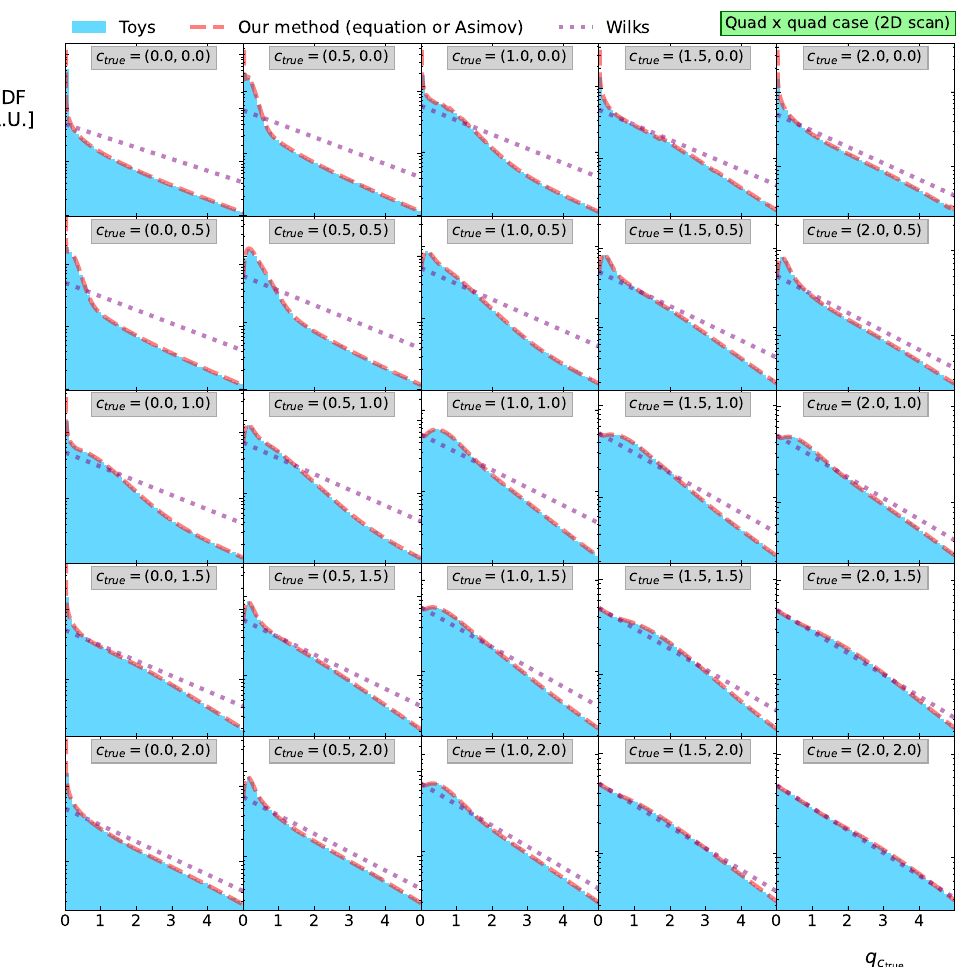
Figure 6: Density of pseudo-experiments compared with our method for a 2D ex- = ( 0.5,0.1 ) , ¯ n = ( 0.4,0.4 ) and a strong positive correlation of ample with ¯ n 1 2 ρ = 0.83. Our method is able to describe cases with c ∼ ( 0,0 ) where Wilks’ theo- true rem is violated.